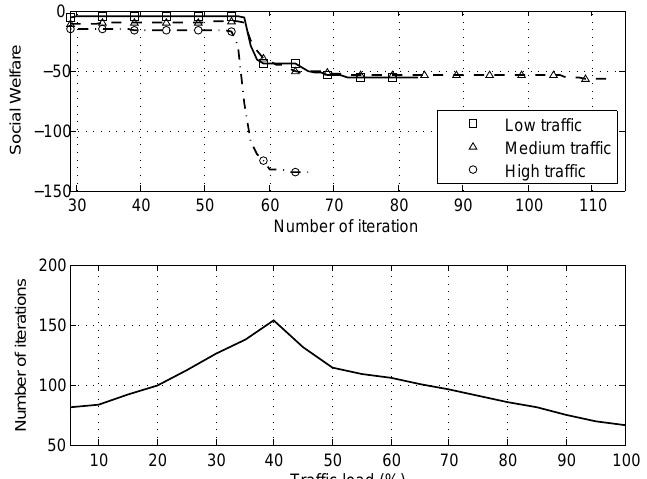
Figure 3. Evolution of social welfare and relation between traffic load and number of iterations for a small market of N = 2 operators and M = 3 SCs.